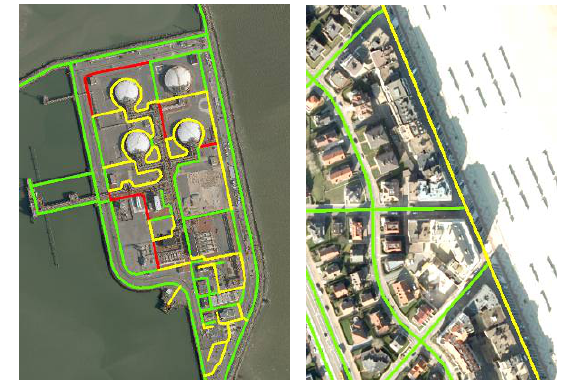
Figure 10: MMV does not contain an appropriate harbour (left) and the sea front model (right) (MMV outcome: correct = green, incorrect = red, undecided =